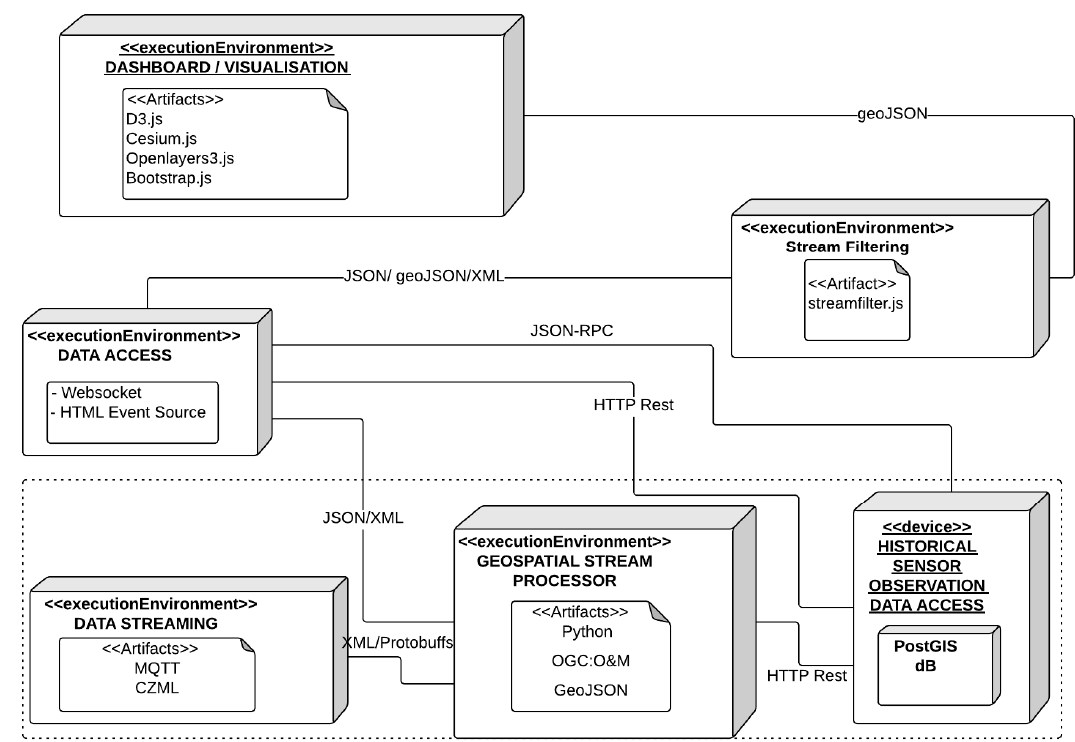
Figure 11. An illustration of deployment nodes of the geoStreamViewer application.